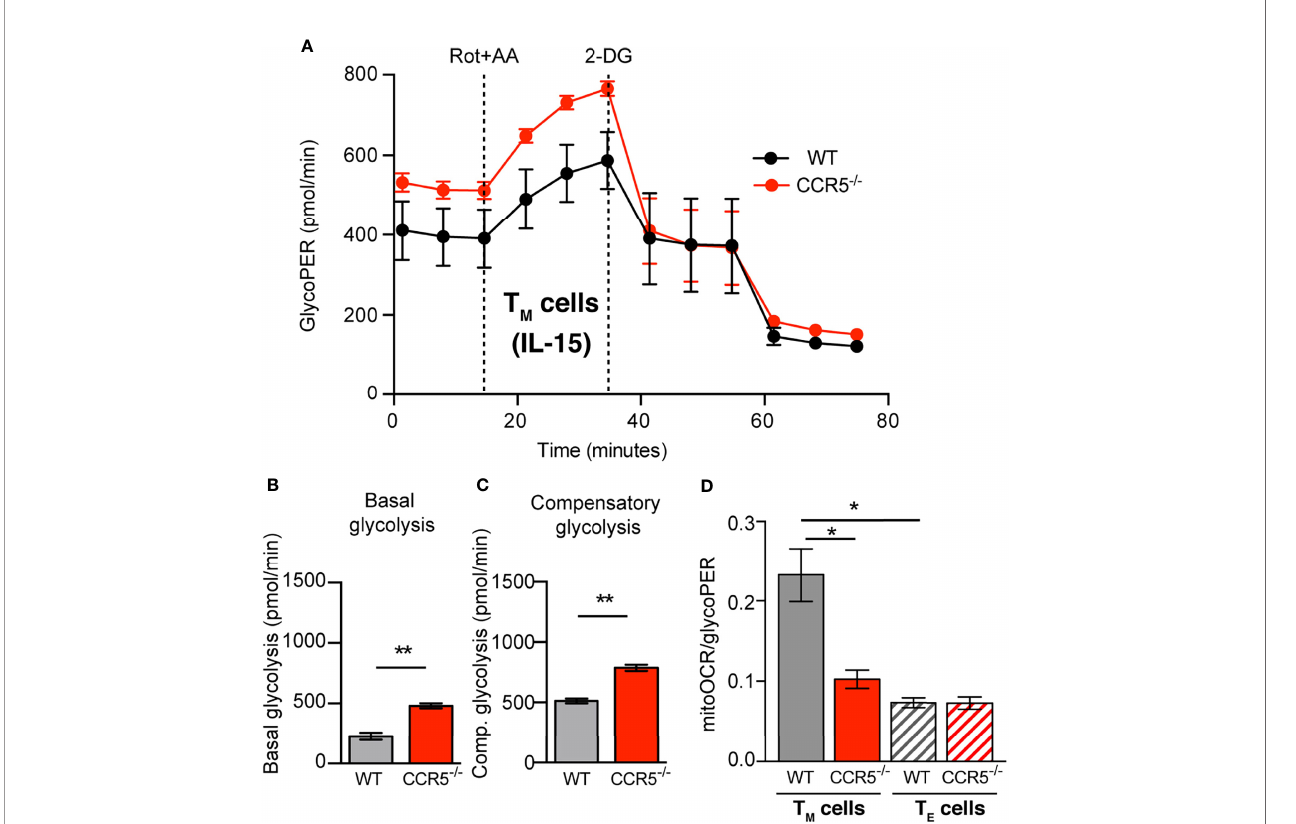
FIGURE 2 | CCR5 de fi ciency prompts glycolytic metabolism over OXPHOS in memory CD4 + T cells. (A) GlycoPER pro fi les in WT and CCR5 -/- T M cells under basal condition (non-buffered XF assay medium pH 7.4, containing 25 mM glucose and 2 mM glutamine 1 mM sodium pyruvate, in the absence of CO 2 ), and following addition of rotenone/antimycin A (Rot+AA) and 2-DG. (B, C) Basal glycolysis (B) and compensatory glycolysis (C) determined from pro fi les as in (A) . (D) Basal mitoOCR/glycoPER ratio in WT and CCR5 -/- T M (solid bars) and T E (hatched bars) cells. Data are means ± SEM (n ≥ 9 from three independent experiments). **p < 0.01, *p < 0.05, two-tailed Student t test (B, C) , or two-way ANOVA with Bonferroni post-hoc test (D)